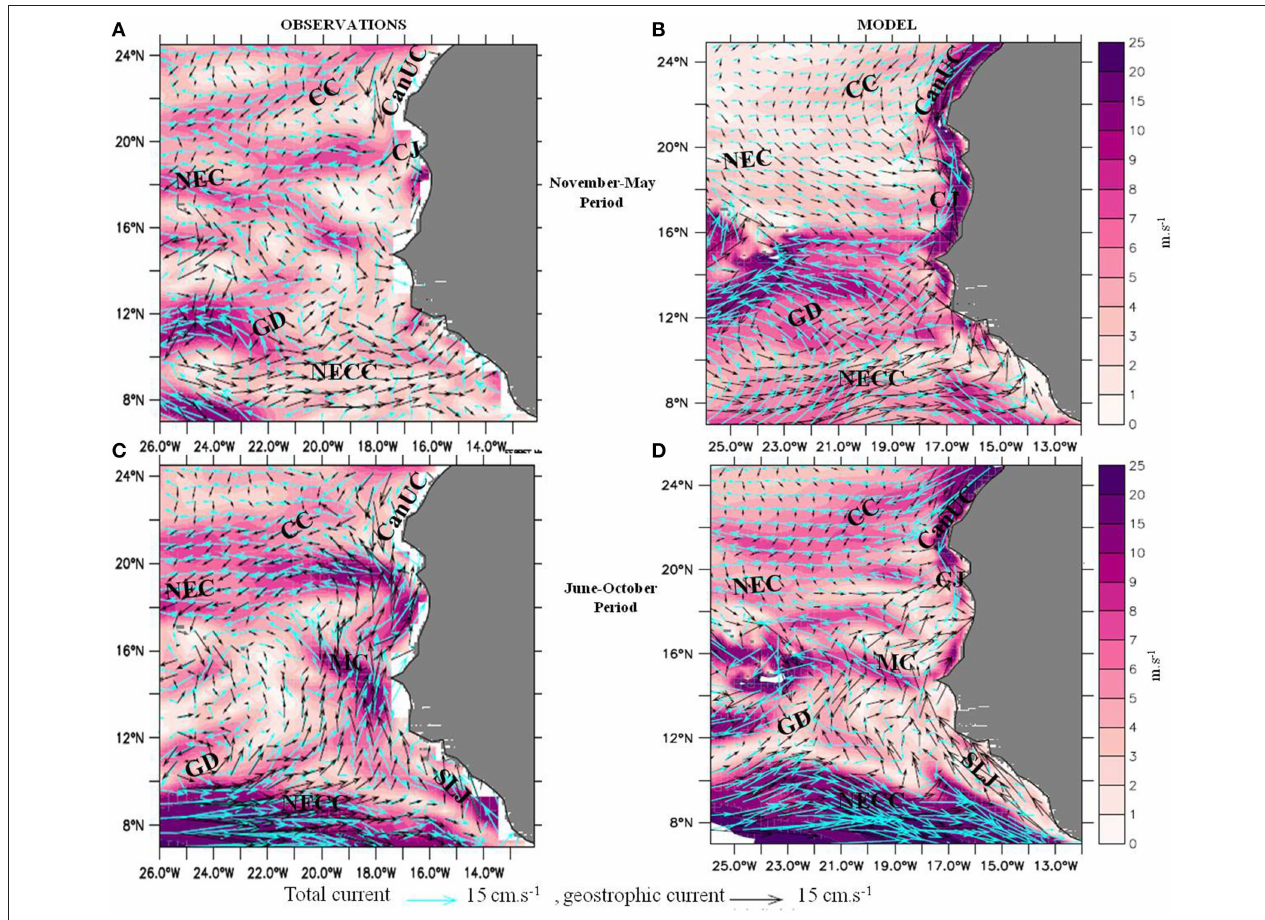
FIGURE 5 | Horizontal surface currents averaged over the CP (November–May, top) and WP (June–October, bottom) for observation-derived (A,C) and simulated (B,D); intensity of the total surface current (shading, m.s − 1 ), total (blue vectors) and geostrophic component (black